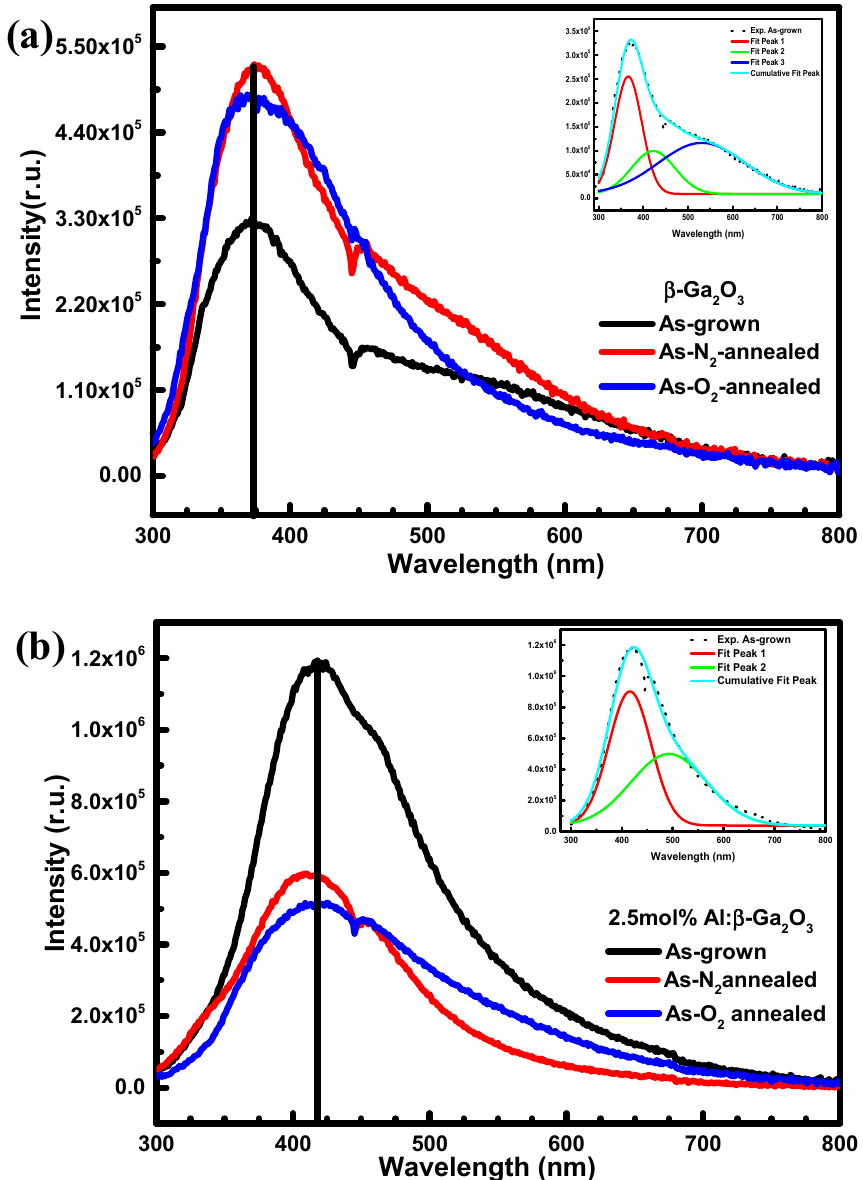
Figure 3. PL emission spectra of ( a ) pure and ( b ) 2.5 mole% Al-doped β -Ga 2 O 3 crystal. The decay time constants of undoped have two components faster ( τ 1 and τ 2 ) and slower ( τ 3 ) with approximate order nanoseconds, and for Al-doped have two faster compo- nents ( τ 1 and τ 2 ) and a slower component( τ 3 ) with approximate values of order nanosec- onds and several hundred nanoseconds, respectively. For undoped as-grown β -Ga 2 O 3 single crystal, the decay time constants are about 5.22, 54.25, and 206.55 ns, and, also, have similar values reported in the previous work [5]. For the undoped β -Ga 2 O 3 , the O 2 /N 2 - annealing will increase the fast component ( τ 1 ), and, also, decrease the proportion of the fast component in the decay time. The increase in the decay time of the undoped β -Ga 2 O 3 crystals after annealing is affected by many factors, and the increase in the concentration of V Ga will also lead to an increase in the decay time. For the as-grown Al-doped β -Ga 2 O 3 , the fast component ( τ 1 ) time is even faster than the undoped β -Ga 2 O 3 and the contribution is as large as 68%. In turn, the O 2 /N 2 -annealing process slightly decreases the fast